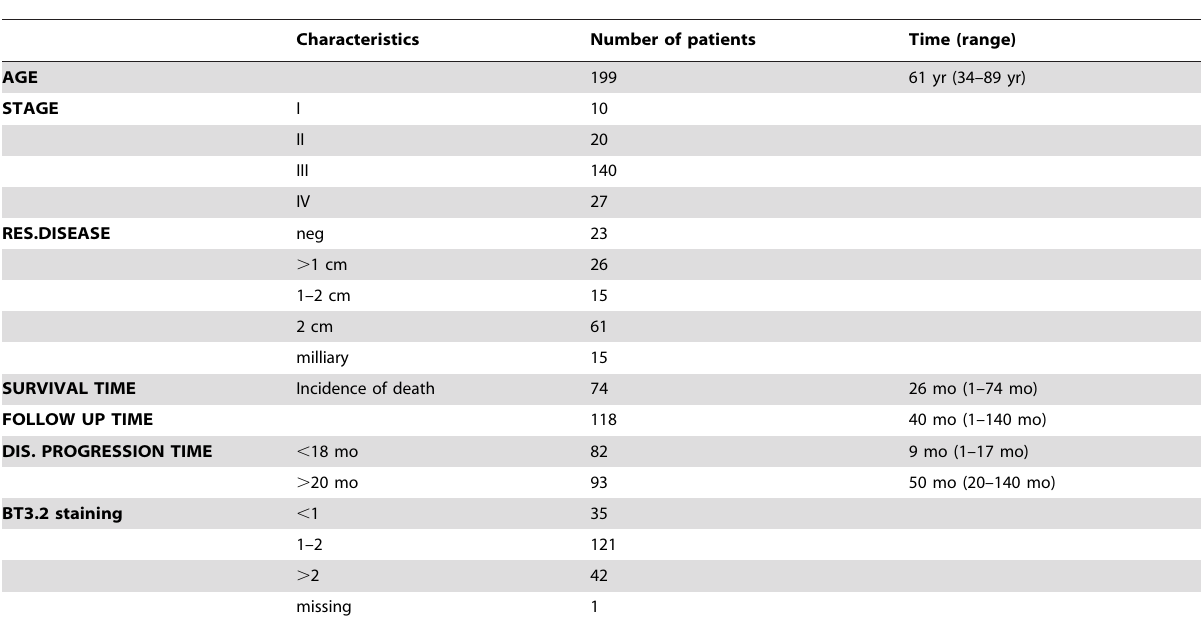
Table 1. Clinical characteristics of the patients included in the